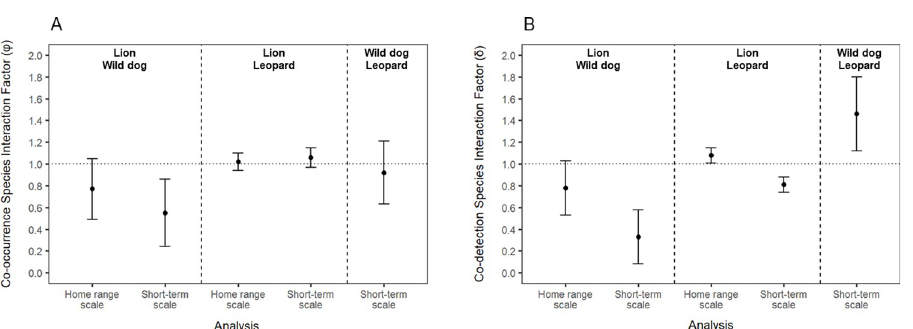
Fig 3. Species interaction factors (SIFs; with respective standard errors) representing the level of co-occurrence ( φ ; A) and co-detection ( δ ; B) between lion, leopard, and wild dog in Ruaha-Rungwa, from the top-ranked model, at the two spatial scales investigated. An SIF value exceeding 1 (dotted line) indicates that the species co-occur more often than expected; a value of less than 1 indicates that the species co-occur less often than expected; and a value of 1 indicates that the species are co-occurring